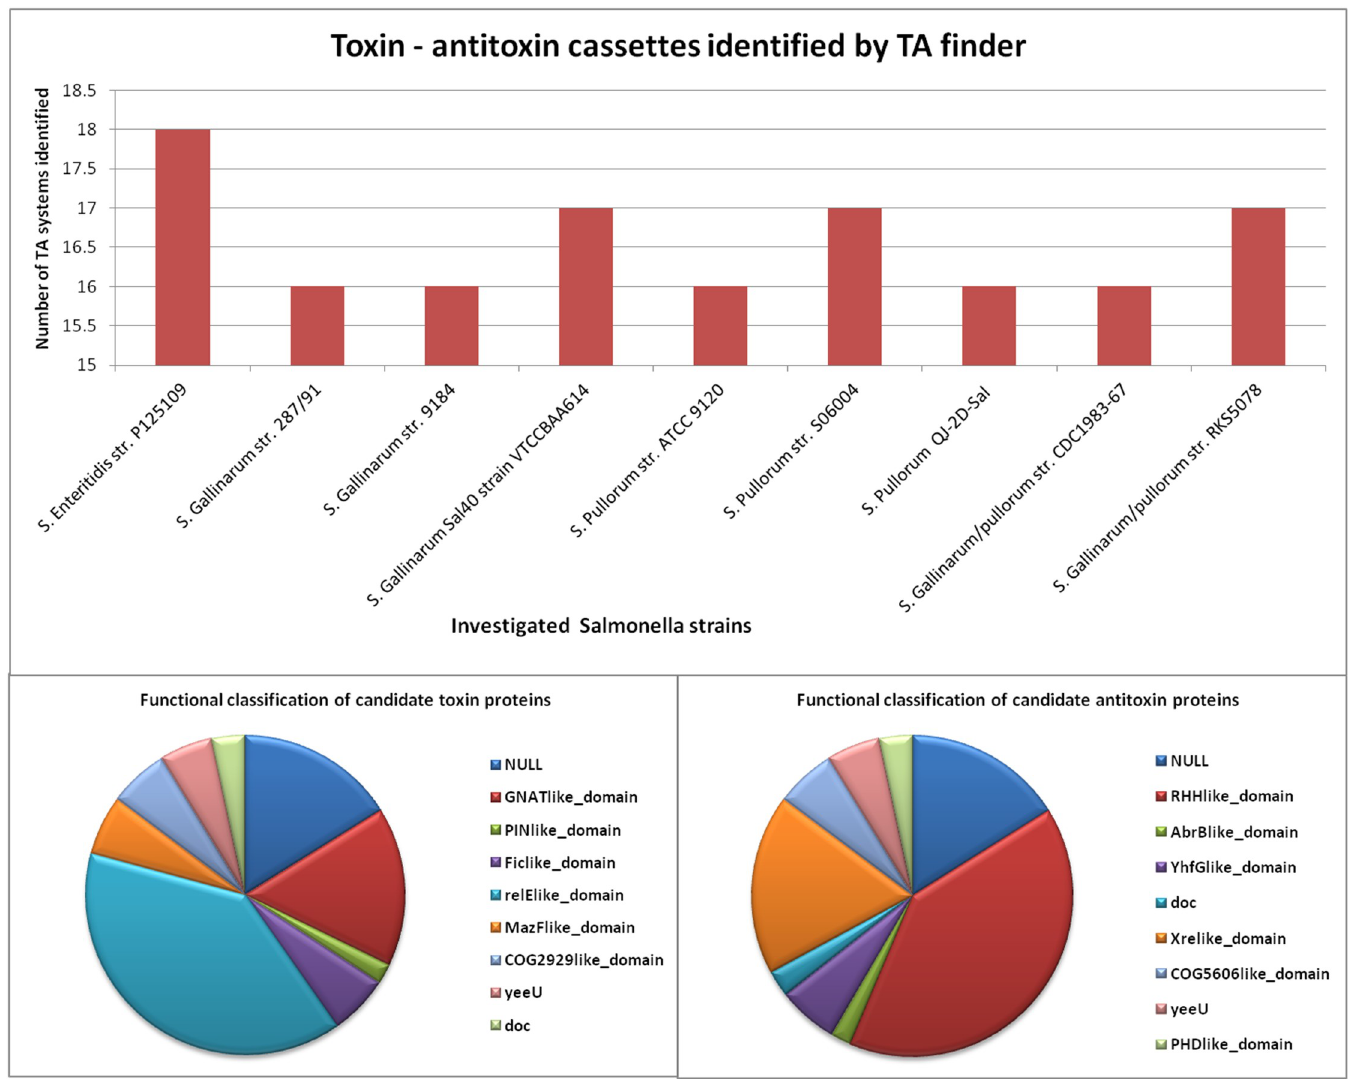
Fig 6. Toxin-antitoxin cassettes identified by TA finder in investigated Salmonella strains with functional classification of candidate toxin and antitoxin proteins.